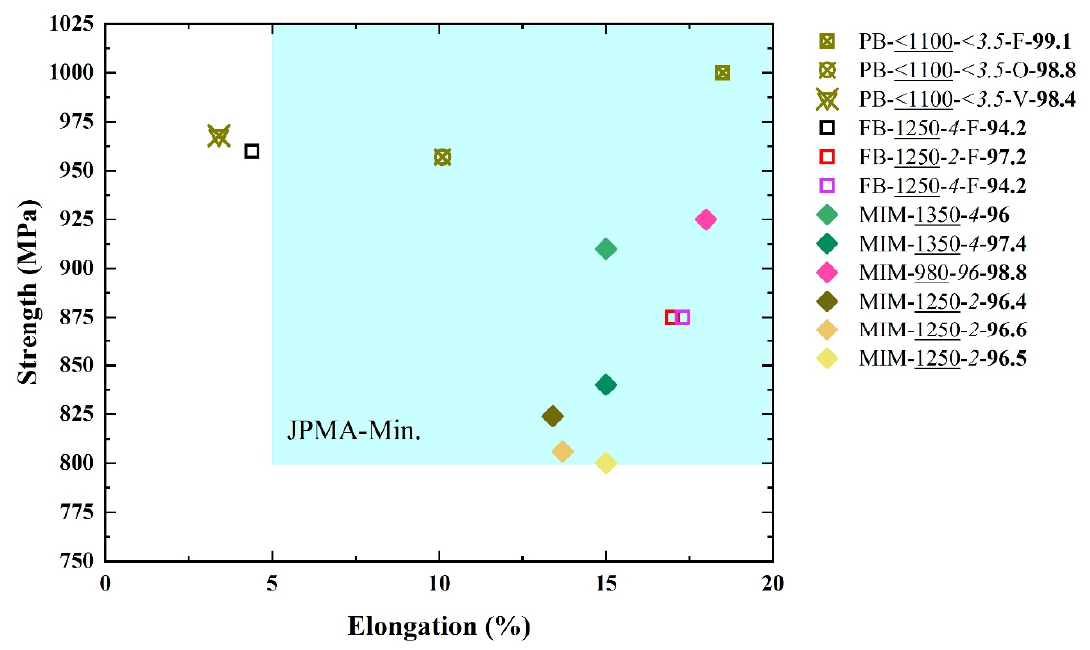
Figure 24. Stress vs. elongation map of Ti-6Al-4V alloy fabricated by the metal MEX process with different conditions comparing with JPMA standard for MIM materials. The underlined number is sintering temperature (°C), the italic number is sintering time (h) and the bold number is relative sintered density (%). Data from [78,79,109,163,164,170].